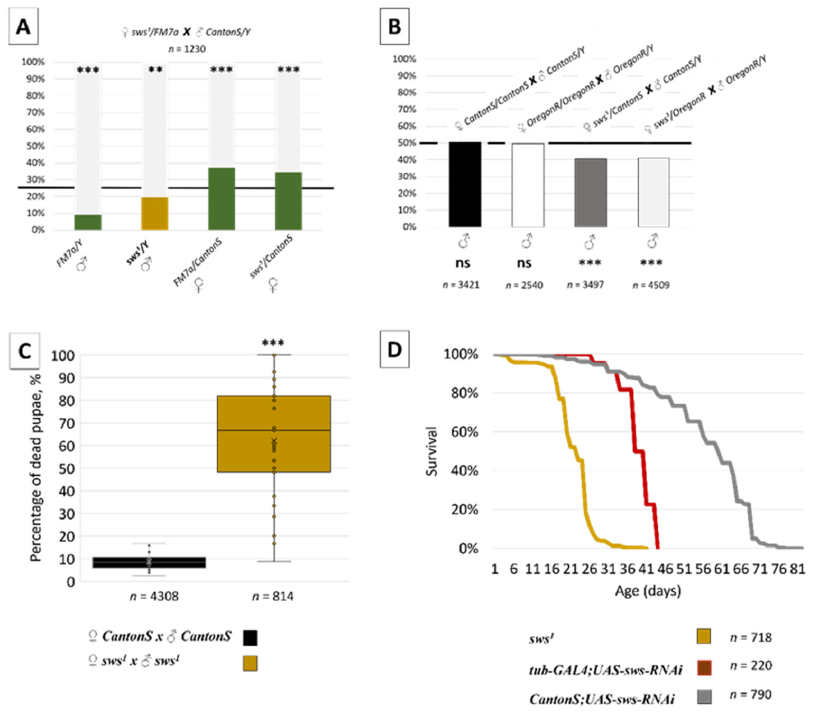
Figure 4. Lethality and survival analysis. ( A ) Percentage of different genotypic classes in the F1 progeny, obtained from crossing sws 1 /FM7a females with CantonS males. The total number of the first-generation imagoes is designated as n . A chi-squared statistical test was applied to test a hypothesis of unequal segregation in F1, ** p < 0.01, *** p < 0.001. Note that there are fewer mutant males than expected. ( B ) Percentage of the total male number in the F1 generation, obtained from different crossings. The total number of the first-generation imagoes is designated as n . A chi-squared statistical test was applied to test a hypothesis of une- qual segregation in F1; *** p < 0.001; ns—no significant difference ( p > 0.05). Note that there are fewer males in F1 than expected only in cases where sws 1 males are expected to be born. ( C ) Percentage of dead pupae in the F1 progeny, obtained from CantonS or sws 1 parents. The total number of the analysed first-generation pupae is designated as n . Mann–Whitney test; *** p < 0.001; the sample size is 30 examined vials. Note that there are much more dead pupae in the progeny of sws 1 mutant parents than of wild type CantonS parents. ( D ) Percentage of living imagoes with different genotypes depending on their age. The total number of counted imagoes is designated as n (100%).